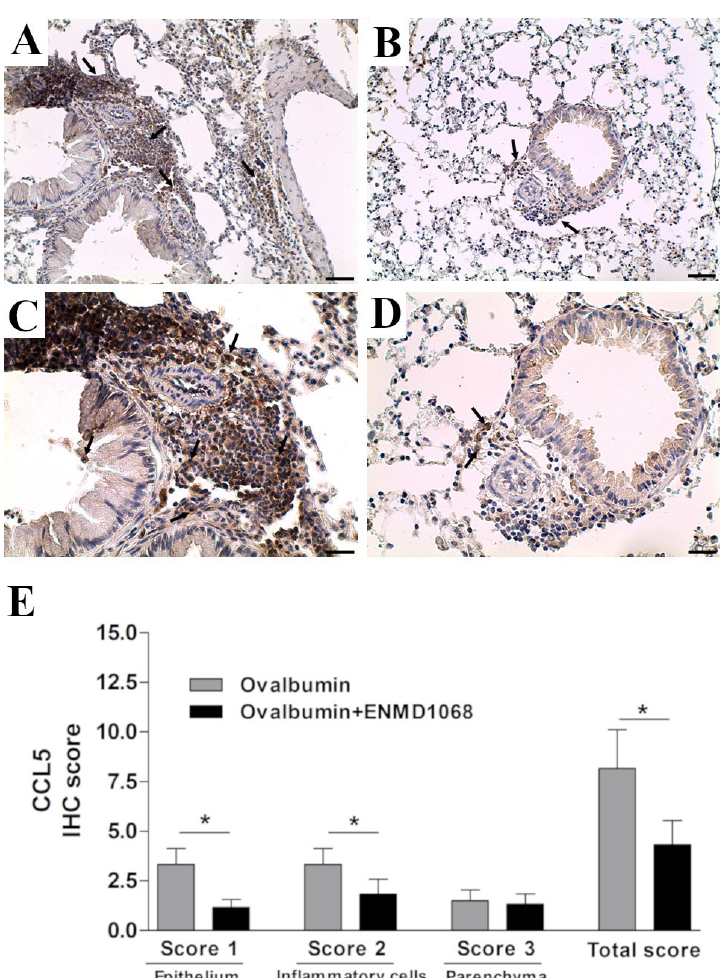
FIGURE 5 - CCL5 localization in lung following PAR2 peptide antagonist ENMD1068 administration after multiple exposures to OVA in lungs of sensitized mice. Representative histological sections of lungs of mice immunostained for CCL5 expression 48 hours after the last intranasal allergen challenge. Ovalbumin-sensitized mice were instilled with OVA (A, C) or pretreated with ENMD1068 1 h before intranasal instillation of OVA (B, D). Pictures were taken under a 20X objective (A, B) and insertion was evaluated under 40X objective (C, D), scale bar = 50 μm. The black arrows indicate CCL5 expression in peribronchial regions, and black head arrows indicate CCL5 expression on inflammatory cells. Immunohistochemistry (ICH) score (E). The results are representative of two independent experiments with similar results, and were expressed as the mean ± standard deviation, n= 6 mice/group. *p<0.05 based on Mann-Whitney